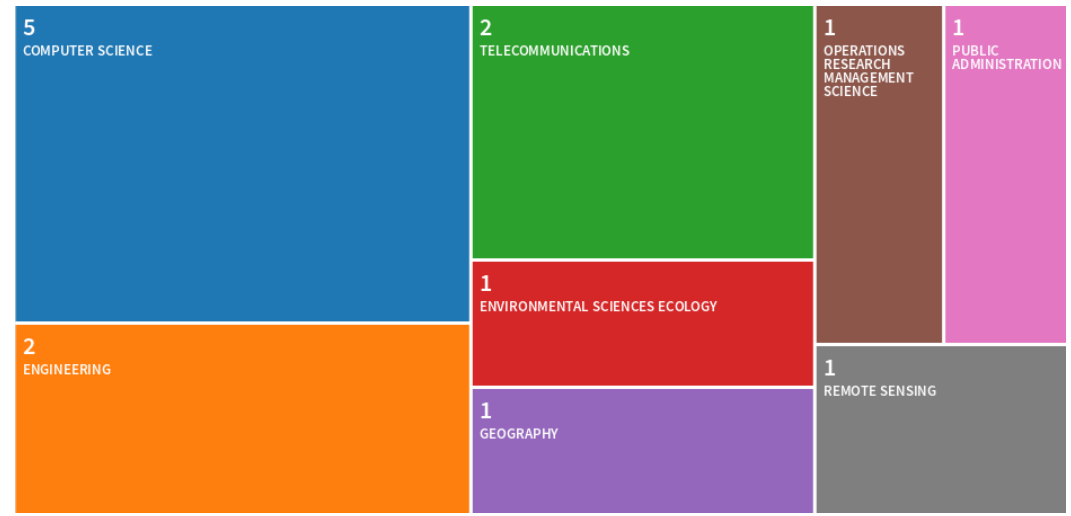
Figure 5. Treemap visualisation of categories of Web of Science found articles, after full-text